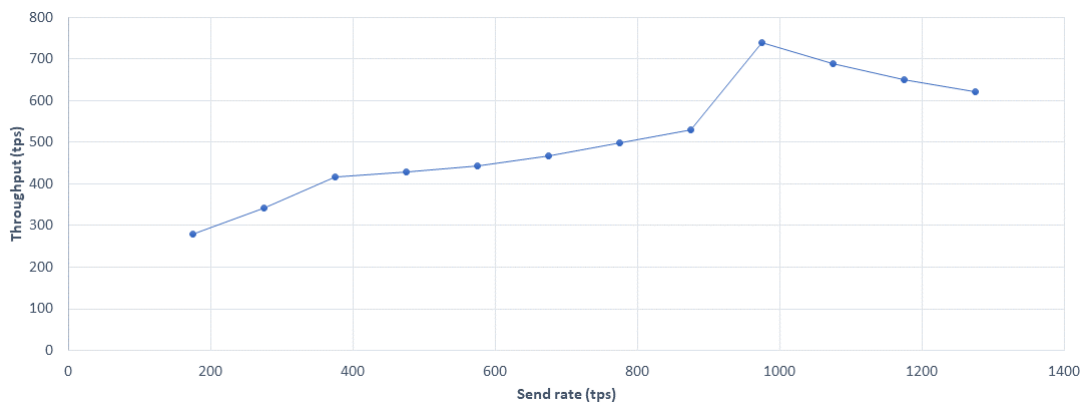
Figure 14. Average transaction throughput